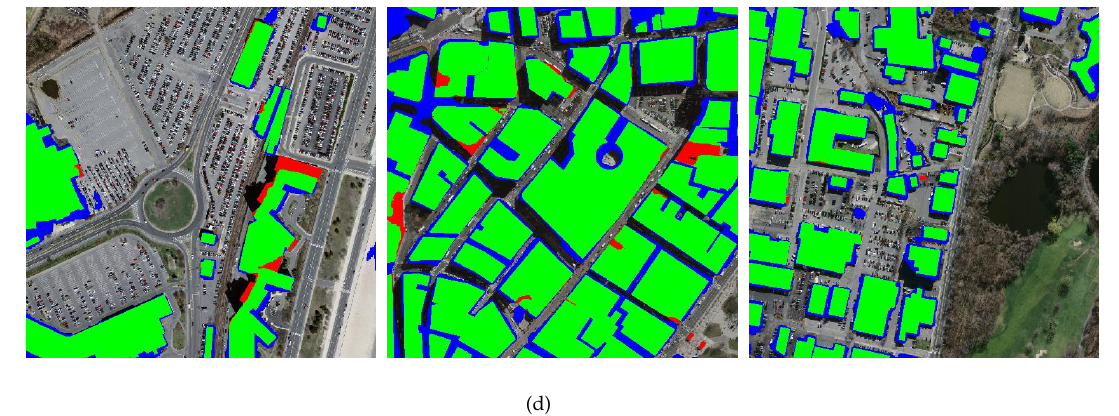
Figure 6. The building extraction results of: ( a ) STEB-UNet on the WHU dataset; ( b ) U 2 -Net on the WHU dataset; ( c ) STEB-UNet on the Massachusett dataset; ( d ) U 2 -Net on the Massachusett dataset. The boxes in green, blue, and red indicate true-positive, false-negative, and false-positive classifications, respectively.